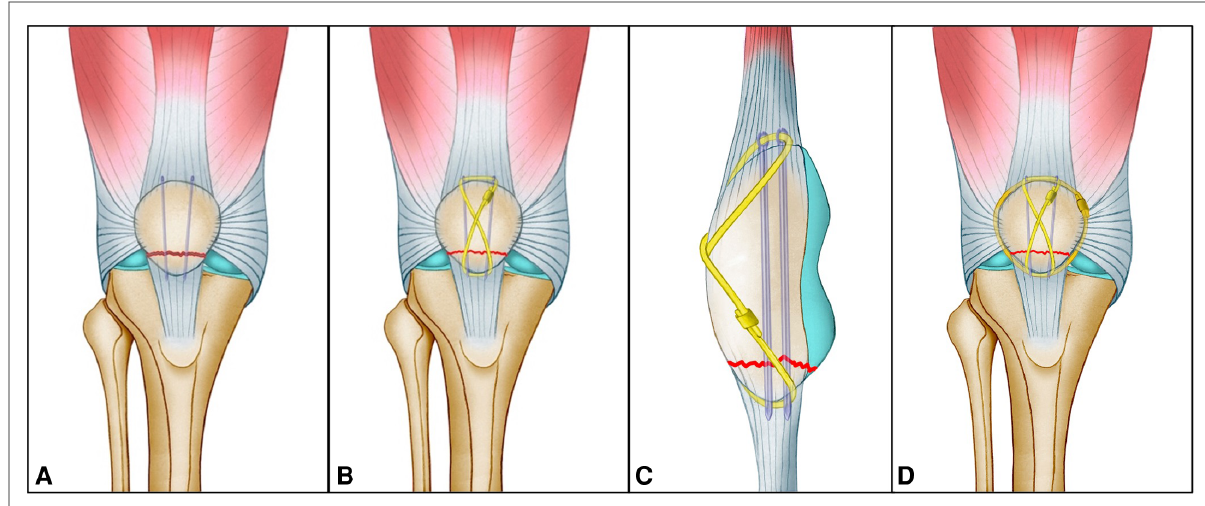
FIGURE 1 Diagrams showing that the displaced inferior patellar pole fracture was reduced and fi xed by a ring-pin combined with cable cerclage. ( A ) Main fragment of the inferior pole threaded by the two ring-pins. ( B ) Anteroposterior and ( C ) lateral views showing insertion of the cable over the front of the patella to form a fi gure-8. ( D ) Final fi xation of the inferior patellar pole